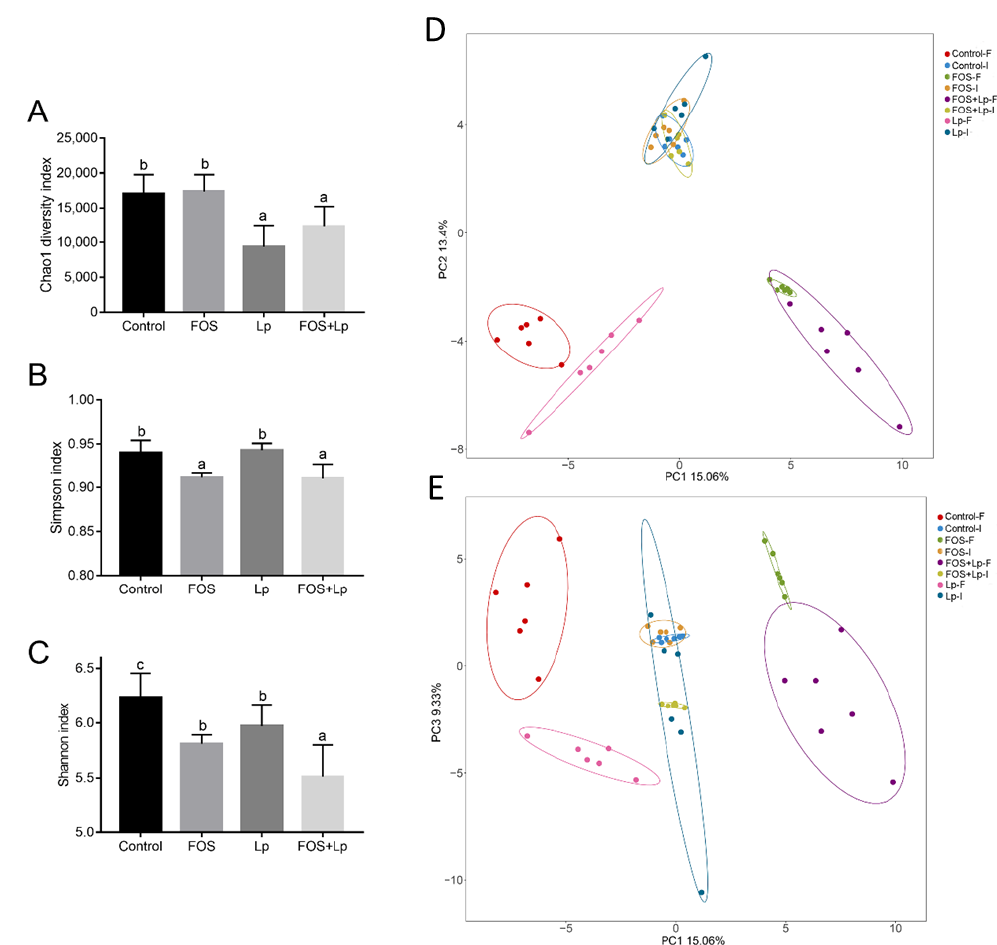
Figure 2. Influence of L. plantarum ST-III and FOS intervention on the gut microbiota. Chao1 index ( A ), Simpson index ( B ), Shannon index ( C ), PCA score plots (PC1*PC2, PC1*PC3), Control-I, FOS-I, FOS + Lp-I, and Lp-I represent the faecal samples from mice at the beginning of animal experiment, while Control-F, FOS-F, FOS + Lp-F, and Lp-F represent the faecal samples from mice reared for 4 weeks ( D , E ). Different letters suggest a remarkable discrepancy according to p value ( p < 0.05) between all groups.